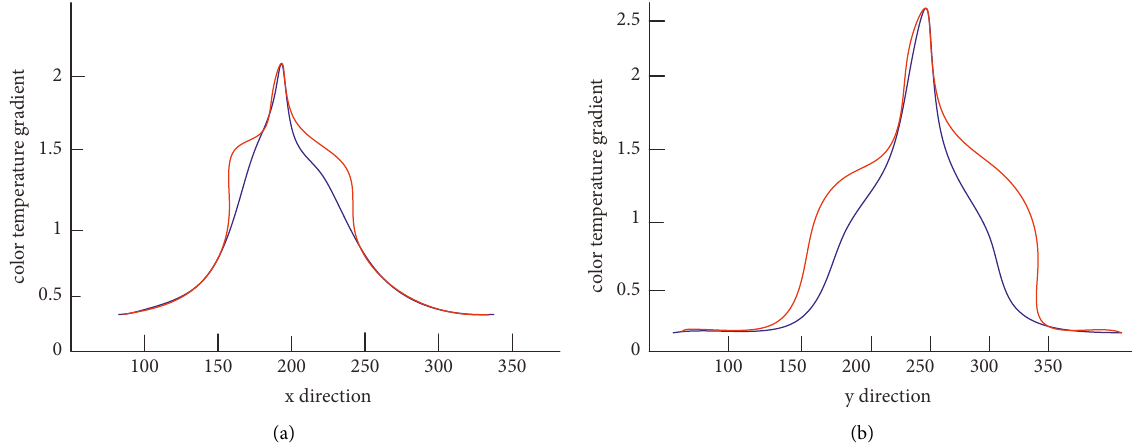
Figure 7: Color temperature gradient map in different directions. (a) Color temperature distribution in the x direction. (b) Color temperature distribution in the y direction.